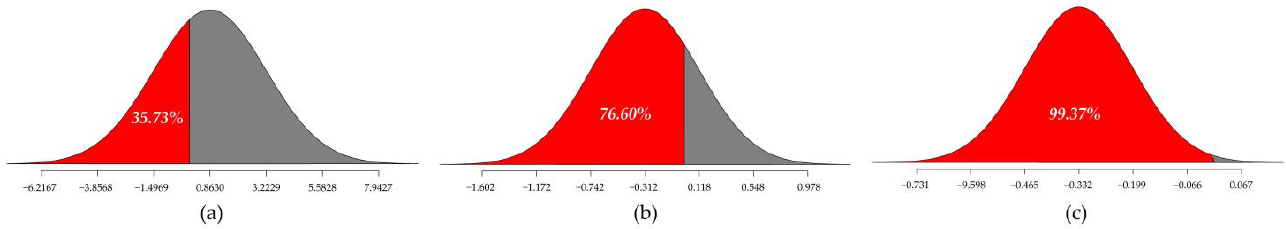
Figure 4. Distribution split of the random parameters. Note: ( a ) gender, ( b ) attitude, and ( c ) annual mileage.